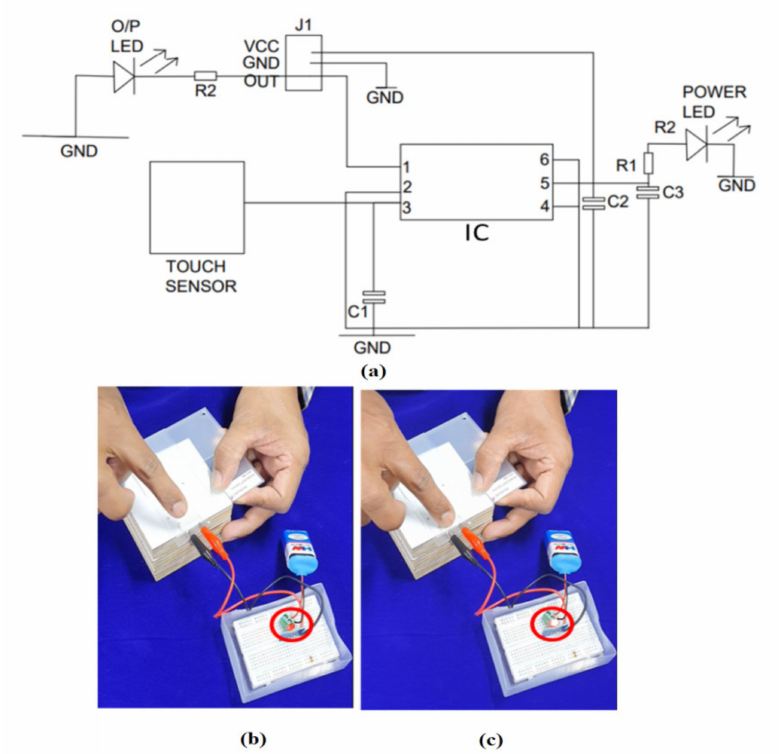
Figure 7. Demonstration of PICS with IVI Bezel ( a ) Circuit Diagram ( b ) Sensor with LED “OFF” ( c ) Sensor with LED